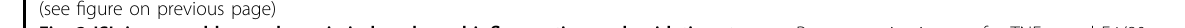
Fig. 3 ISL improved hyperglycemia-induced renal in fl ammation and oxidative stress. a Representative images for TNF- α and F4/80 immunohistochemistry staining using the formalin- fi xed renal tissues as speci fi ed in Methods and materials (×400 magni fi cation). b Western blot analysis for the protein expression of p-JNK, JNK, p-p38, p38, p-ERK, and ERK in three kidney tissue extracts, each from a different mouse. c , d The mRNA expression of pro-in fl ammatory genes IL-6 and MCP-1 in the kidney tissues was determined by real-time qPCR. e Representative images for DHE and 3-NT immunohistochemistry staining using the formalin- fi xed renal tissues as speci fi ed in Methods and materials (×400 magni fi cation). f Western blot analysis for the protein expression of Nrf-2 and GAPDH in three kidney tissue extracts, each from a different mouse. g , h The mRNA expression of anti-oxidation genes Nrf-2 and HO-1 in the kidney tissues was determined by real-time qPCR (A minimum of fi ve mice per group were used for analysis. * P < 0.05, *** P < 0.001 vs control (Veh); ### P < 0.001 vs